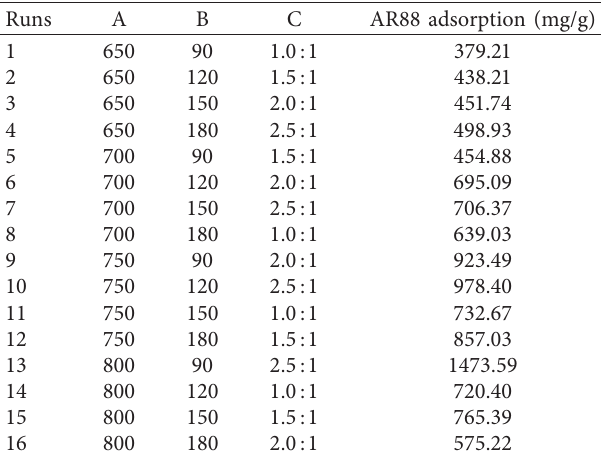
Table 2: Results of the orthogonal experiment.